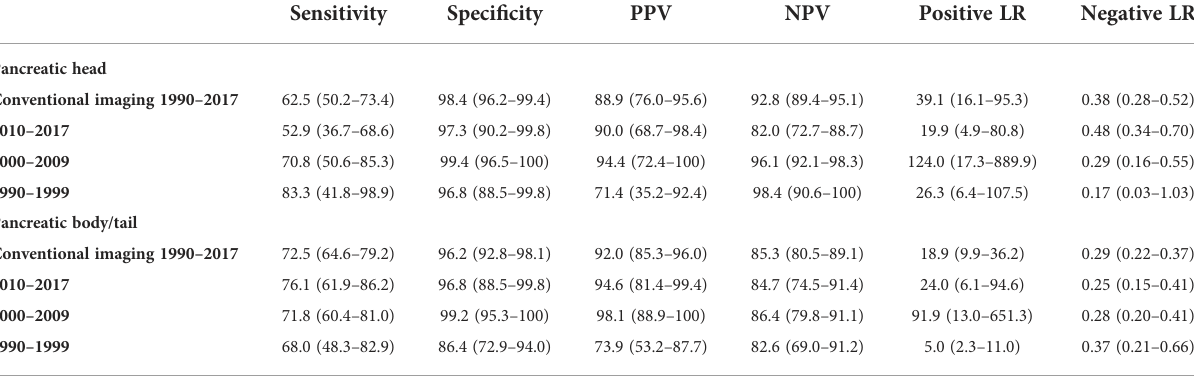
TABLE 2 Diagnostic accuracy of conventional imaging (CT/MRI/EUS) 1990 – 2017.